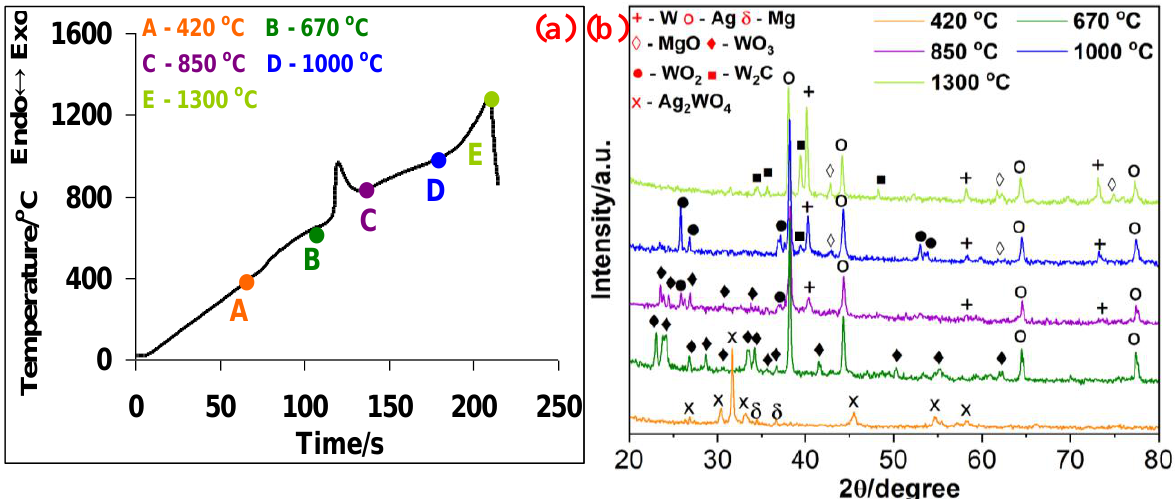
Figure 7. Heating curve of the Ag 2 WO 4 + 2Mg + 2C mixture, β = 300 °C min −1 ( a ) and XRD analysis results of quenched samples ( b ).